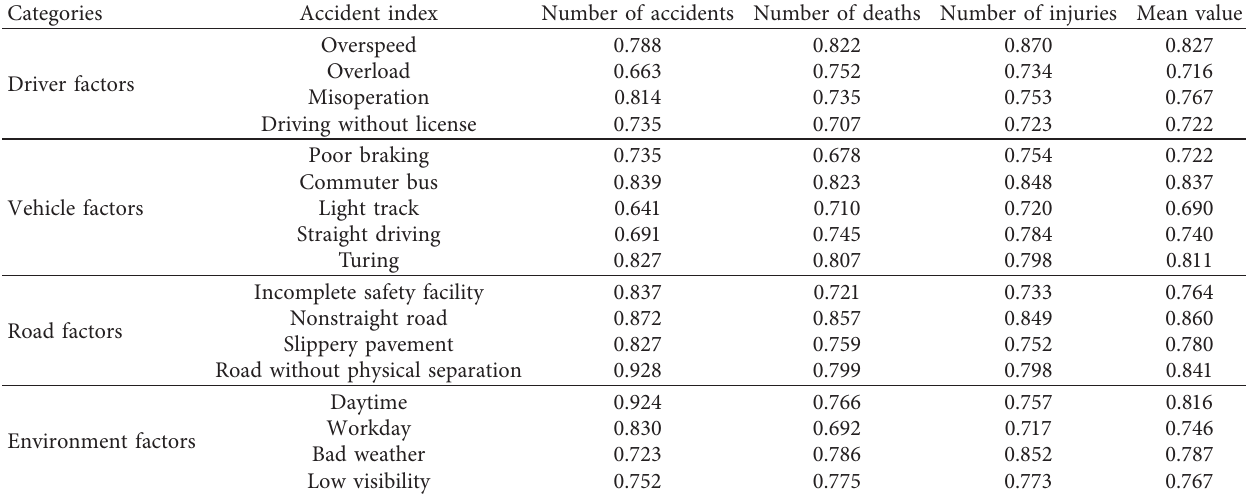
Table 4: The weighted grey correlation degree of single-vehicle traffic accidents’ factors.